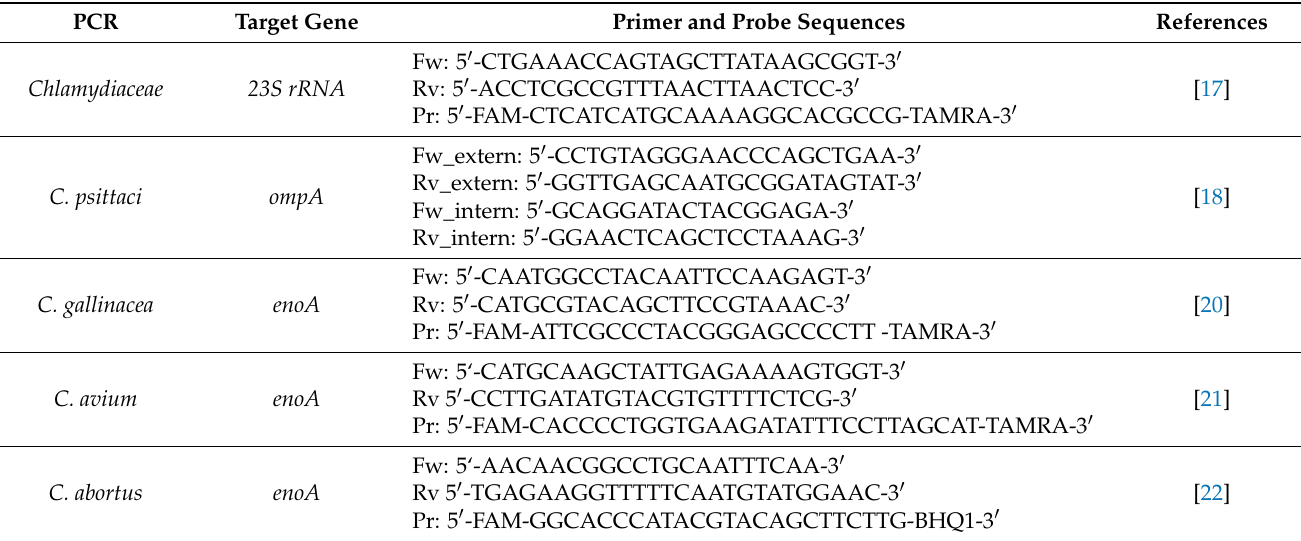
Table 1. Target gene and primer and probe sequences for the different PCR assays. Primer and Probe